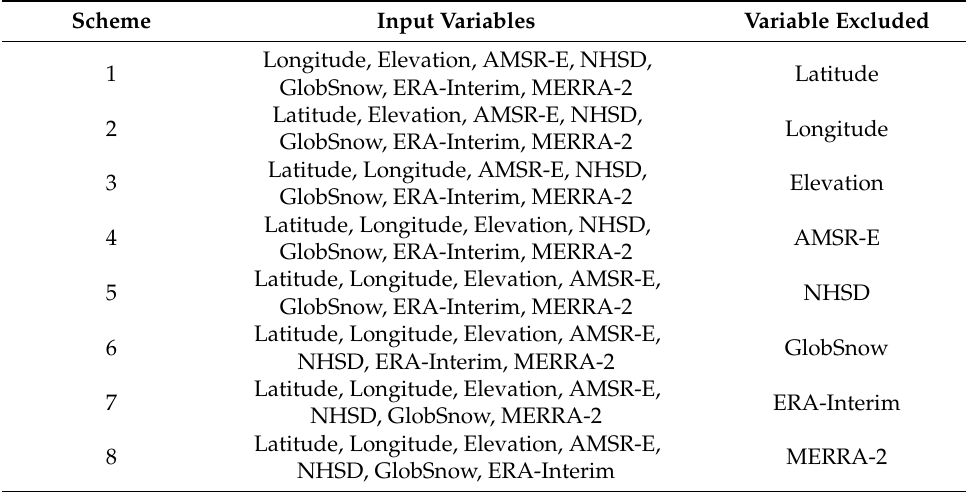
Table 3. Different schemes of input variables for Random Forest Regression.